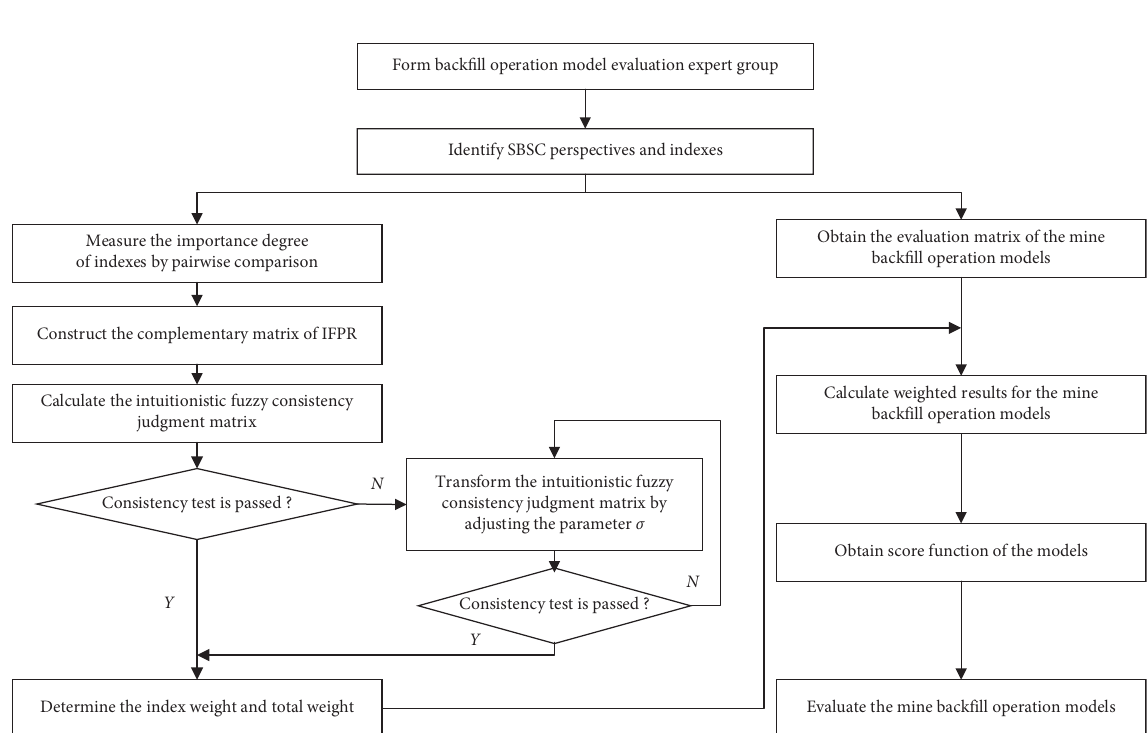
Figure 3: Flow chart of evaluation of mine backfill operation models.